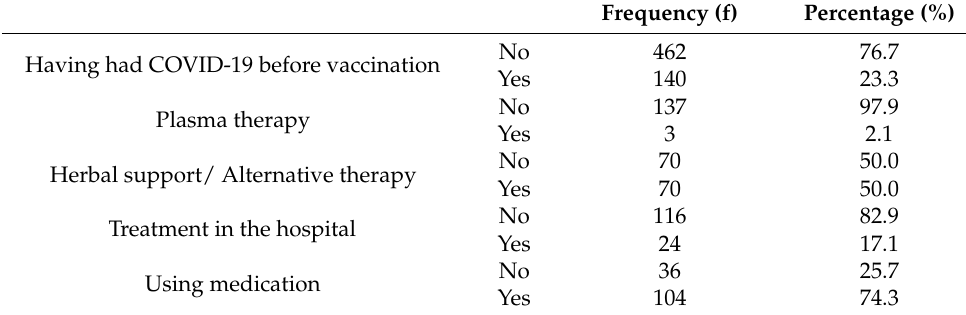
Table A2. The status of COVID-19 infection and treatment before